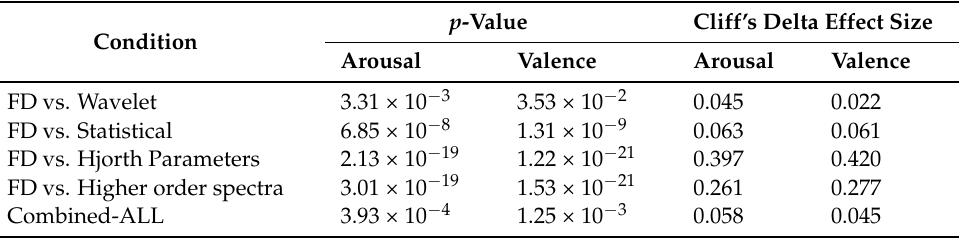
Table 5. Statistical results ( p -values effect size) of two-tailed paired t -test of CART classification performances among different feature